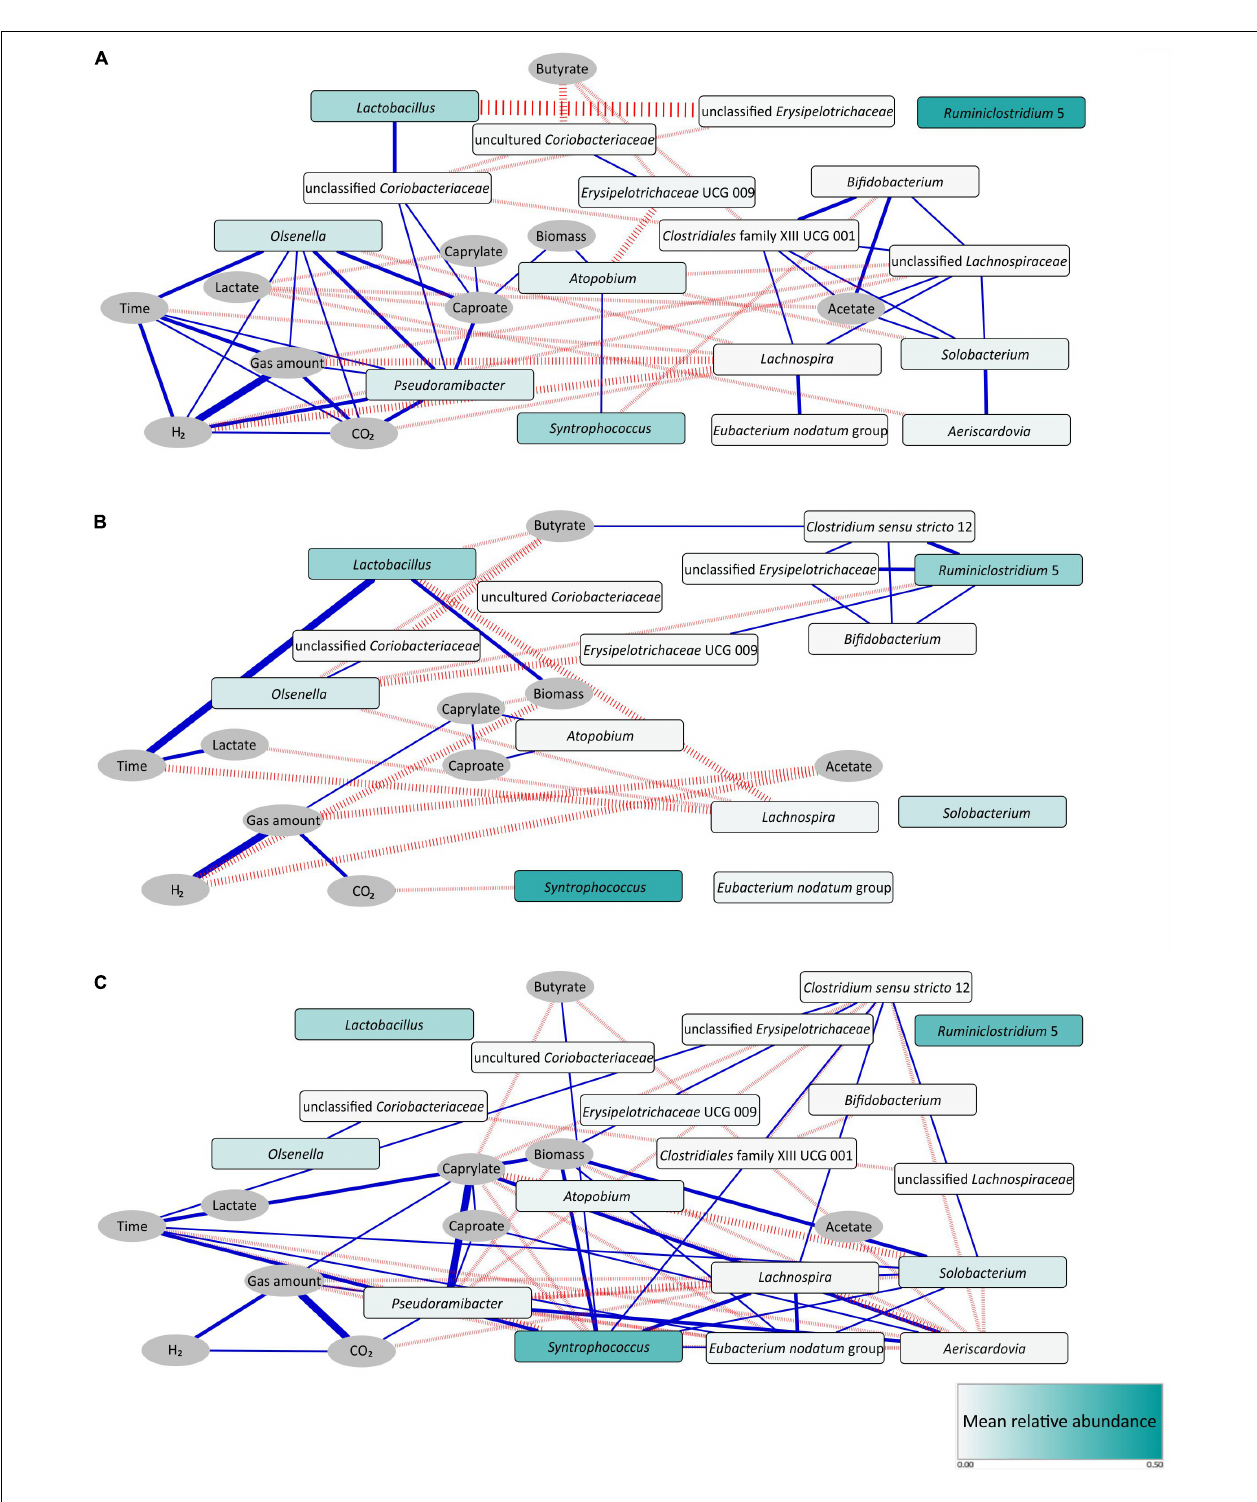
FIGURE 5 | Correlation networks for stage I (A) , stage II (B) , and stage I - transition stage - stage II (C) . Pearson, Spearman, and Kendall correlation coefficients were computed for each pair of microbial taxa (rectangular nodes) and abiotic parameters (elliptic nodes) over the respective period using absolute taxon abundances. Edges indicate a coefficient > 0.75 for positive correlations (blue edges) and < –0.75 for negative correlations (red edges). Edge thickness indicates the number of methods supporting the correlation (1 to 3). Shading of the microbial taxon nodes indicates mean relative abundance over the respective period. Note the identical node layout in both networks. To ease comparison, also unconnected nodes are shown that feature correlations in the other network. However, unconnected nodes with zero abundance were removed, like Pseudoramibacter and Aeriscardovia in the network of stage II.